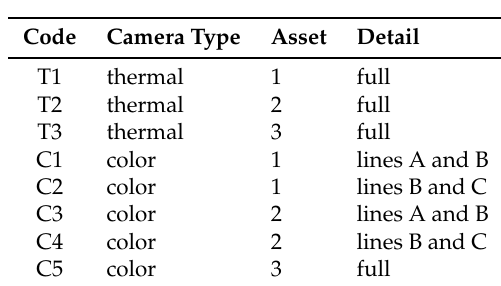
Table 1. Experiments